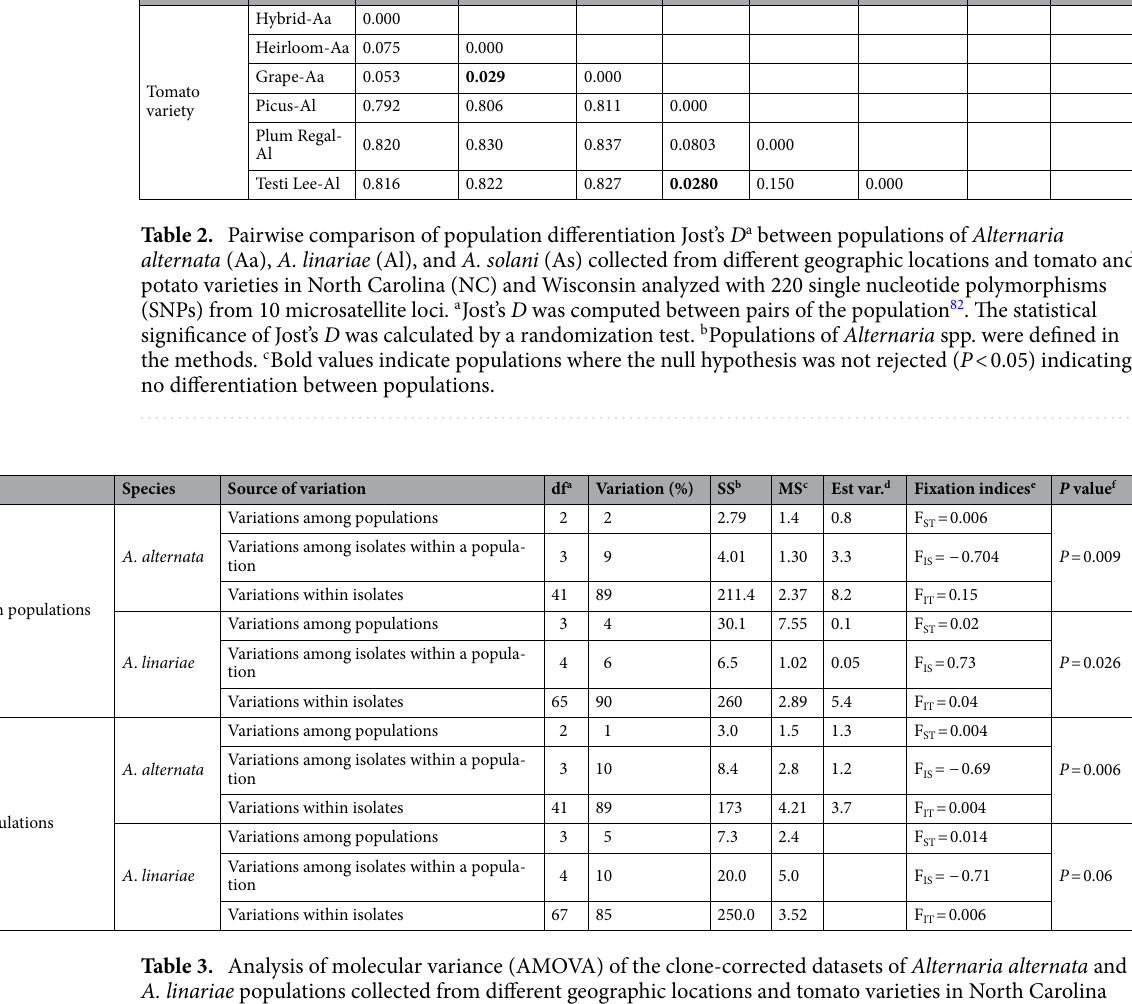
population SWA-Al was close to HAY-AI and clustered separately from the MAD-AI and MAC-AI populations (Supplementary Fig. S10). Linkage disequilibrium. We calculated the standardized index of association ( r d ) in clone-corrected data to infer the LD . We found nonsignificant LD ( P > 0.05) between species and most populations within a species (Table 4 and Supplementary Figs. S11, S12, and S13). Intriguingly, LD values in two populations, STO-Aa and Heirloom-Aa, significantly ( P < 0.05) deviated from the hypothesis of recombination.